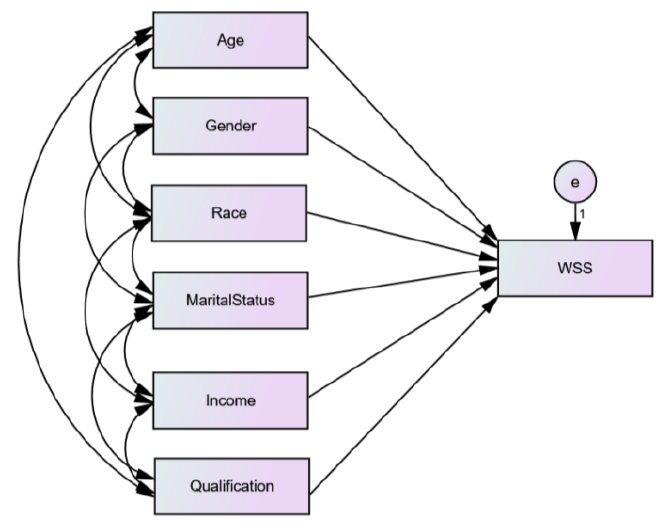
Figure 1: Hypothesize input